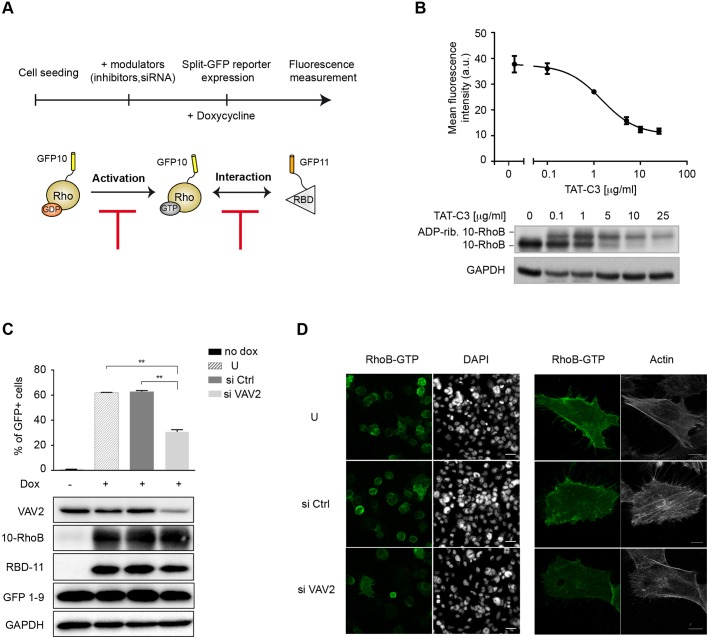
Analysis of modulation of RhoB activity. (A) Experimental workflow used to evaluate inhibitors of Rho activation by using the triSFP Rho reporter system; inhibitors or siRNAs were added prior to split-GFP expression. A decrease in split-GFP fluorescence will report either a decrease of the amount of the active GTP-Rho form or the inhibition of the Rho–RBD interaction. (B) Dose–response inhibition of the RhoB reporter with TAT-C3 exoenzyme (0.1 to 25 µg/ml). The mean fluorescence intensity was analyzed by flow cytometry. Results are mean±s.e.m.; n=3. As shown in the blot underneath the graph, an analysis of RhoB expression (anti-GFP10) confirmed the ADP-ribosylation (rib.) of RhoB that induces a shift of the RhoB band. (C) Percentage of GFP fluorescent cells for RhoB reporter cells left untransfected (U) or transfected with scrambled siRNA (siCtrl) or siRNA targeting the RhoGEF VAV2 (siVAV2). Results are mean±s.e.m.; n=3 independent experiments. **P<0.01 (Student's t-test). Expression of VAV2 and triSFP components is shown below (anti-GFP10 and anti-GFP11 antibodies; GFP1-9, antibody against full-length GFP). (D) Representative images of untransfected (U), siCtrl and siVAV2-transfected cells visualized by fluorescence microscopy. Left, wide-field images of cells expressing active RhoB (FITC channel); DAPI nuclear staining. Scale bars: 50 µm. Right, representative confocal images of RhoB-GTP and actin labeling (Phalloidin–Alexa-Fluor-594). Scale bars: 10 µm.